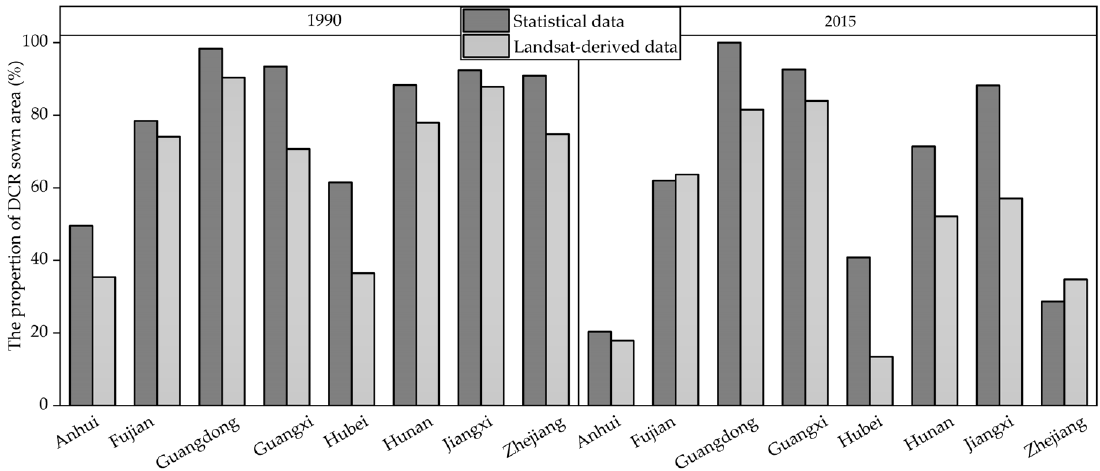
Figure 7. Comparison of proportions of double-cropping rice (DCR) sown area to the total rice sown area in Southern China from Landsat and statistical data at the provincial